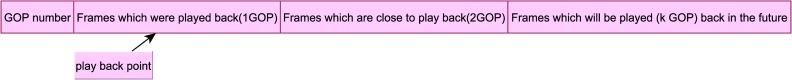
Vehicles buffer map.